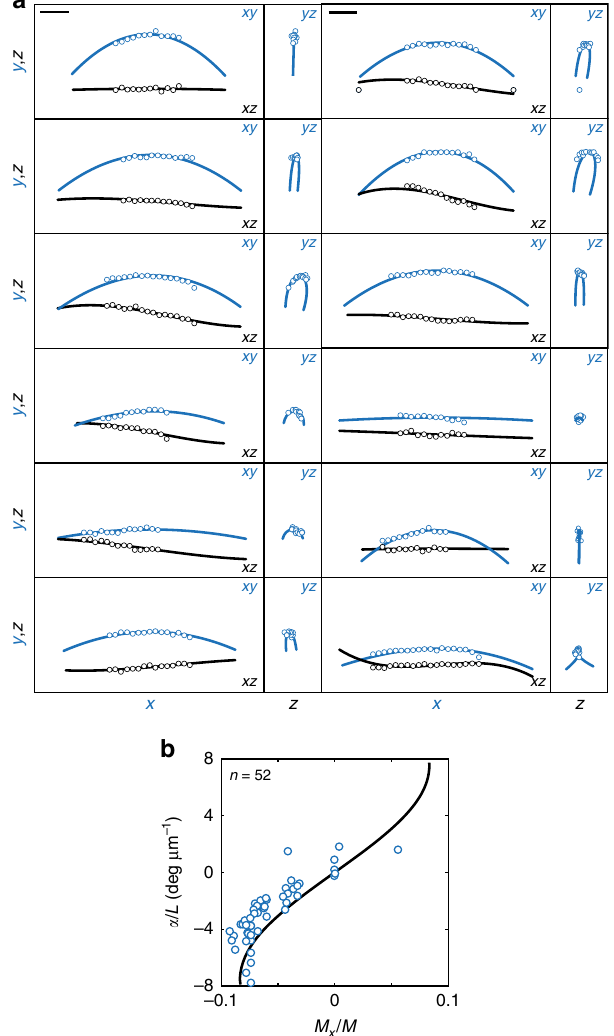
Fig. 4 Comparison of theory and experiments. ( a ) Theoretical fi ts (curves) to the traces of microtubule bundles from horizontal spindles in live HeLa cells expressing PRC1-GFP (circles). Three different projections are shown: left, horizontal xy projection (blue), and xz projection (black); right, yz projection (blue). Parameters are, left column: M = (0, − 5,180), ( − 5, − 23,113), ( − 10, − 68,117), ( − 8, − 55,69), ( − 3, − 26,27), (4,18,68) pN μ m, right column: M = ( − 11, − 43,159), ( − 20, − 94,208), ( − 5, − 31,108), (0, − 2,8), (1,0,154), ( − 8,167,71) pN μ m. Parameter L is taken from measurements. The other parameters are d = 1 μ m and κ = 900pN μ m 2 . ( b ) Theoretical curve representing twist of a microtubule bundle, α , divided by spindle length, L , as a function of the twisting moment, M x = M ix , q ffiffiffiffiffiffiffiffiffiffiffiffiffiffiffiffiffiffiffiffi M 2 þ M 2 (the same curve for normalized to the bending moment, M ¼ iy iz i = 1,2). Circles represent experimental helicity of the traces of microtubule bundles from live HeLa cells expressing PRC1-GFP, as a function of the normalized twisting moment, obtained from fi ts. The parameters of 2 μ